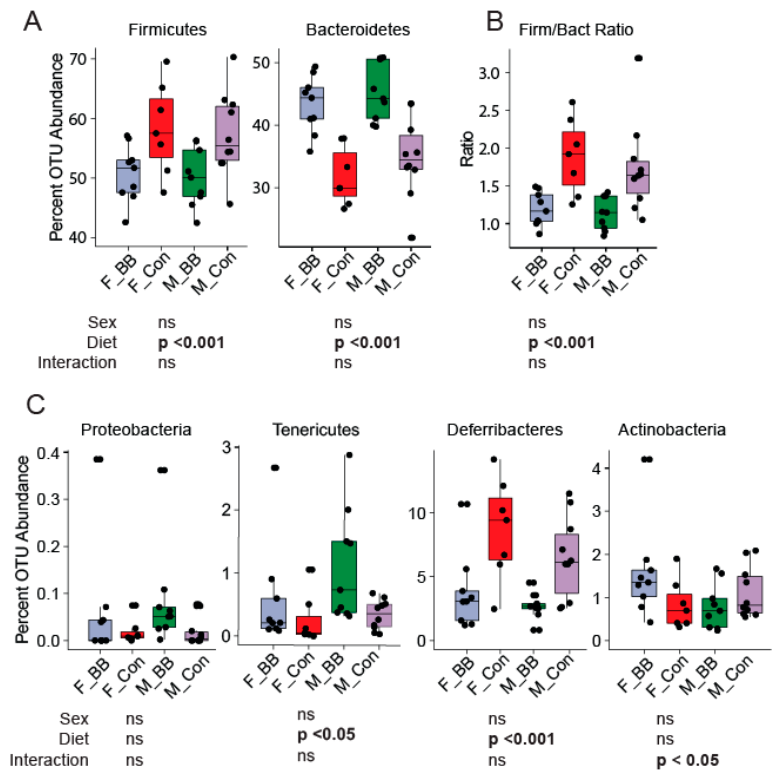
Figure 3. Operational taxonomical unit (OTU) abundance at the phylum level upon blueberry supplementation. ( A ) The OTU abundance of Firmicutes and Bacteroidetes was decreased and increased, respectively, in the blueberry-supplemented groups in both sexes. ( B ) Decreased Firmicutes to Bacteroidetes ratios in the blueberry groups were seen. ( C ) Proteobacteria, Tenericutes, Deferribacteres, and Actinobacteria were also altered by dietary blueberry supplementation. F-BB (female mice fed a blueberry diet) ( n = 9), F-Con (female mice fed a control diet) ( n = 7), M-BB (male mice fed a blueberry diet) ( n = 9), and M-Con (male mice fed a control diet) ( n = 9). Two-Way ANOVA analysis was performed using R. Sex, diet, and their interaction, then these two factors were used to determine the significance. (ns = non significant).